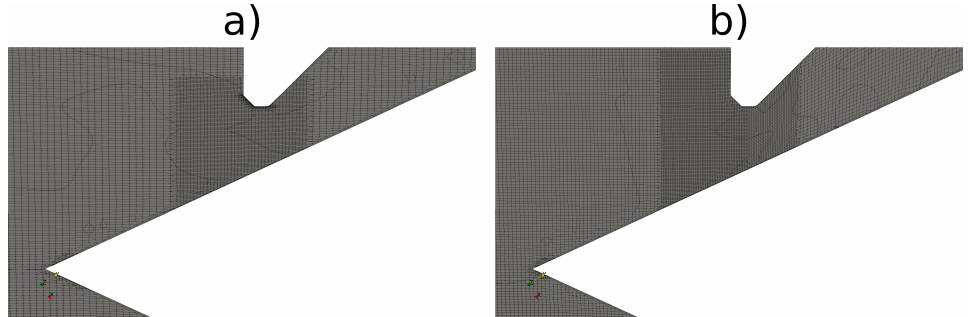
Figure 3. View of the mesh at the nozzle outlet. ( a ) Mesh 1 for the original geometry and a stroke S = 50%. ( b ) Mesh 2 for the original geometry and a stroke S = 50%. Three cell layers are added close to the wall to accurately capture the boundary